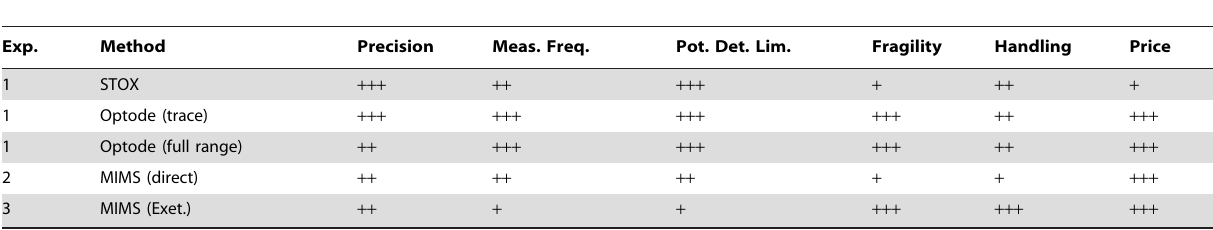
Table 2. Method comparison with respect to precision, detection limit and applicability.